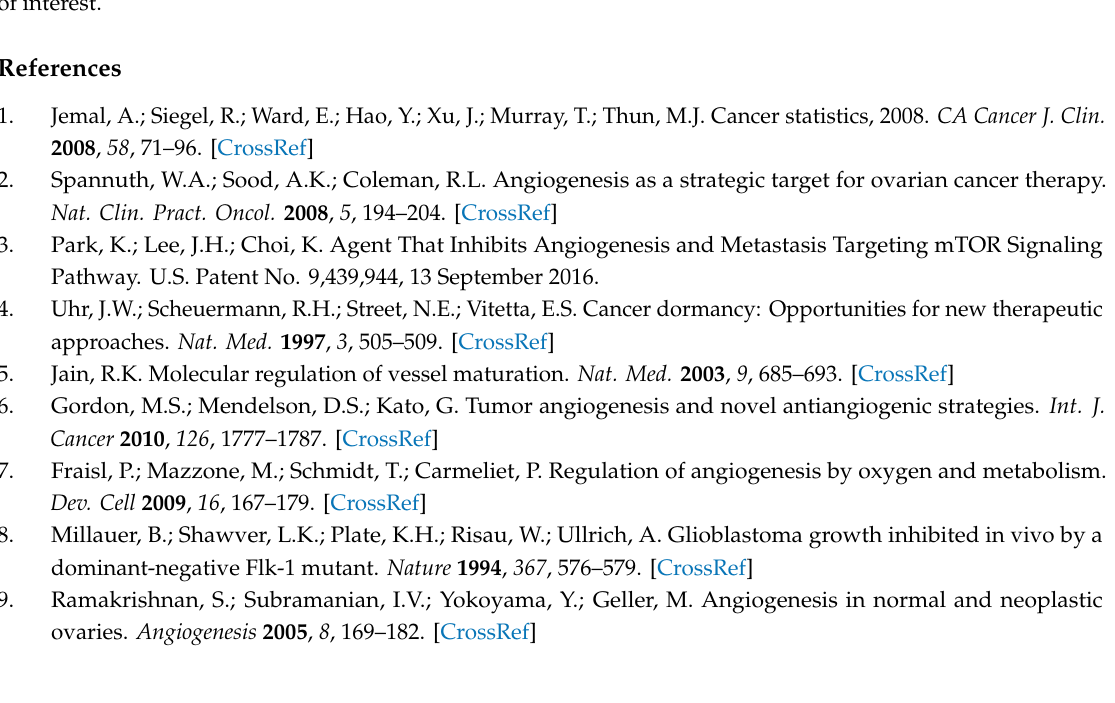
Figure S1: Identification of upstream and downstream signaling pathways involved in angiogenesis inhibition by Msx1 and PIASy, Figure S2: Msx1 protein can interact with VEGFR-2 but not with VEGFR-1, Figure S3: Msx1 suppressed in vivo tumor